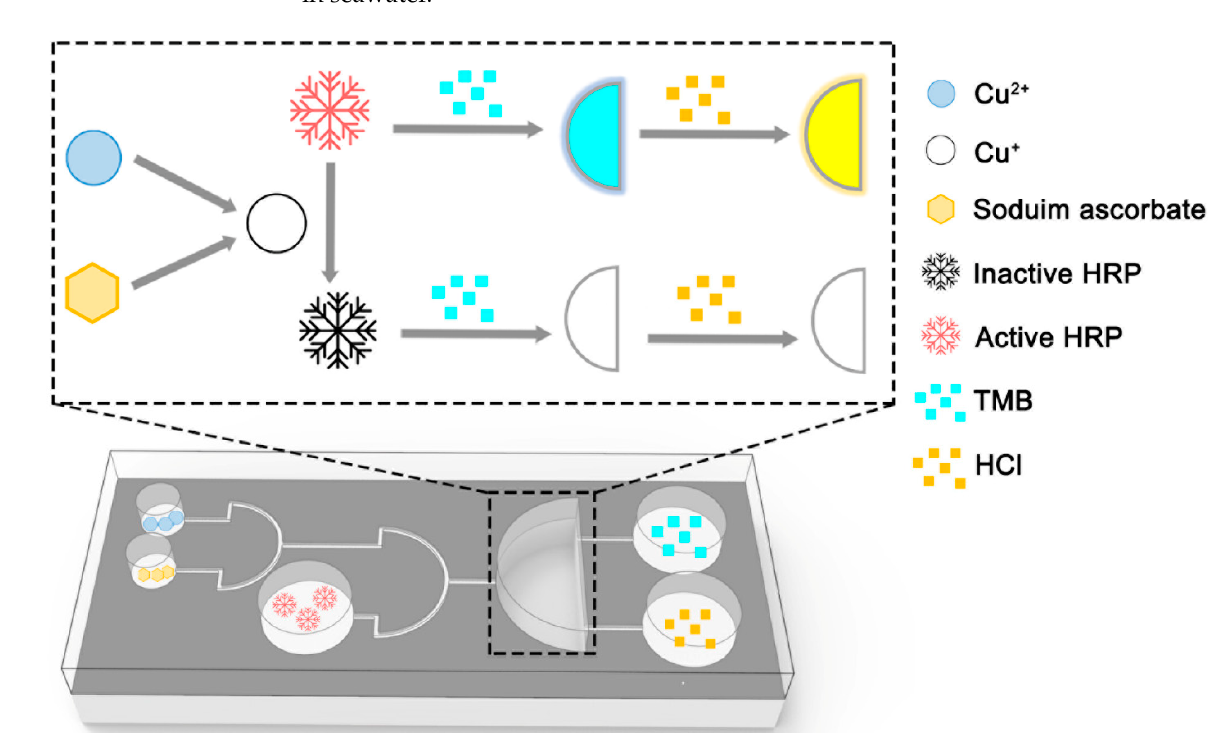
Figure 3. The detection mechanism of the fabricated enzyme method-based microfluidic chip.